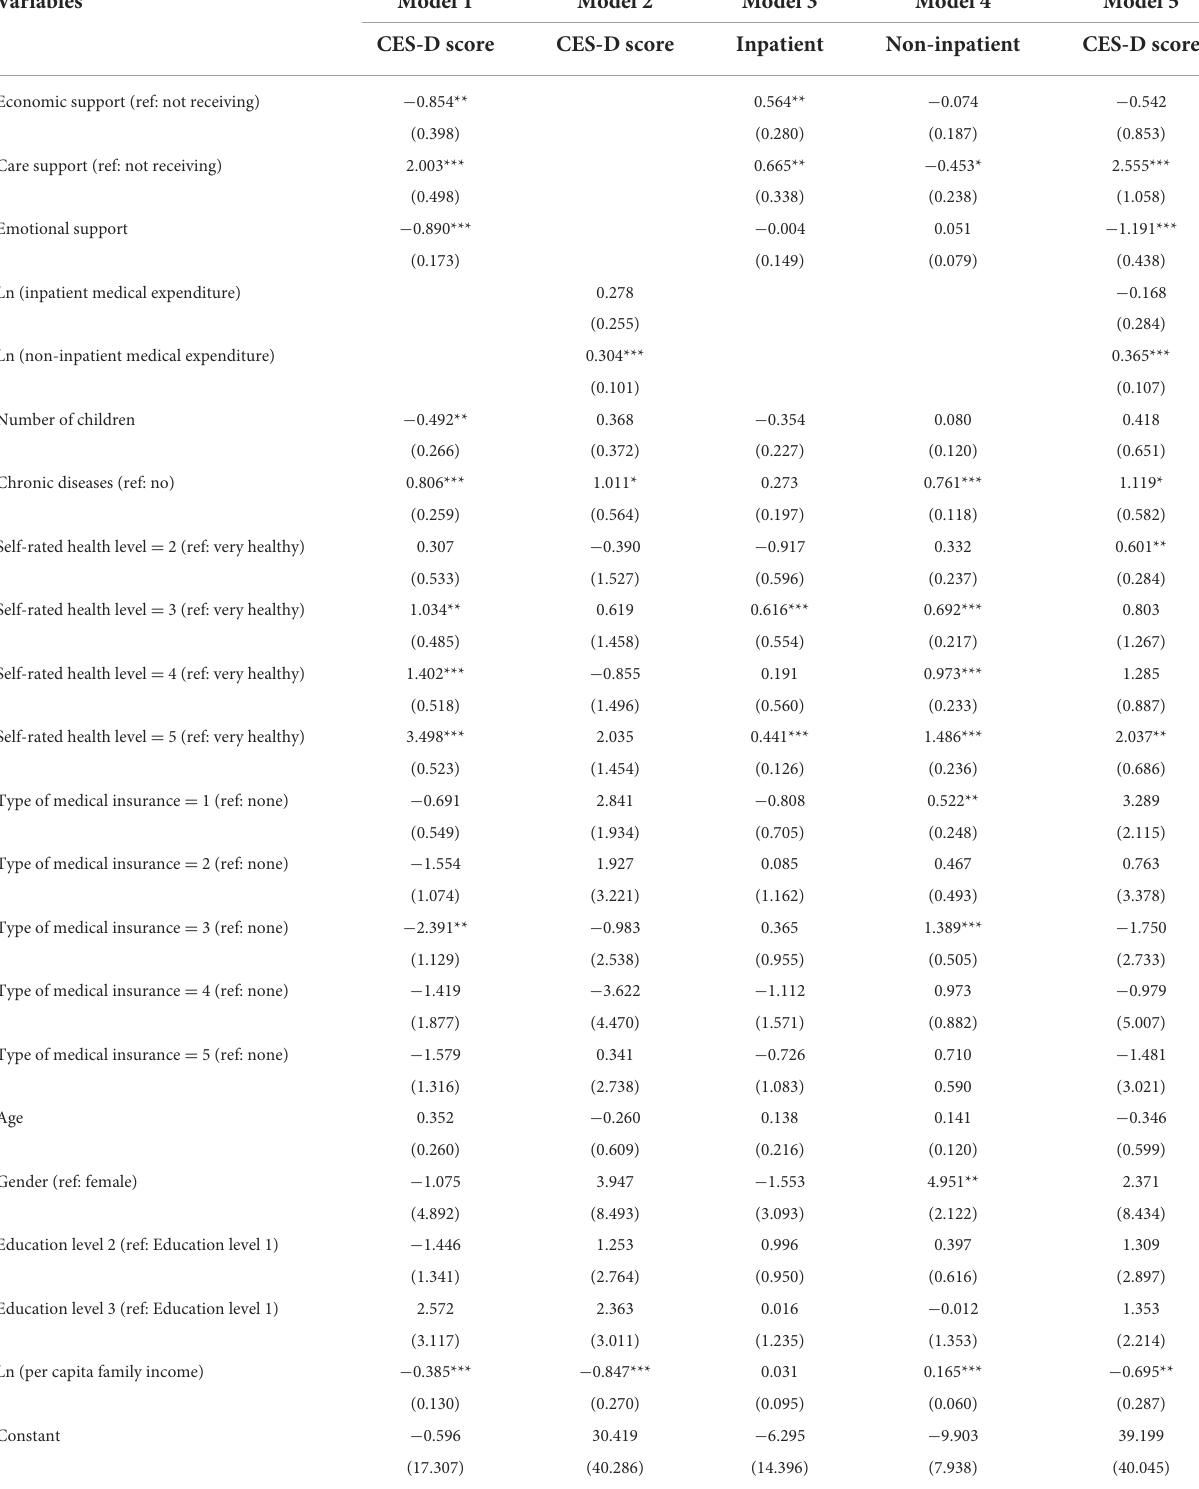
TABLE 3 Regression analysis for intergenerational support and medical expenditures on depression among the rural older